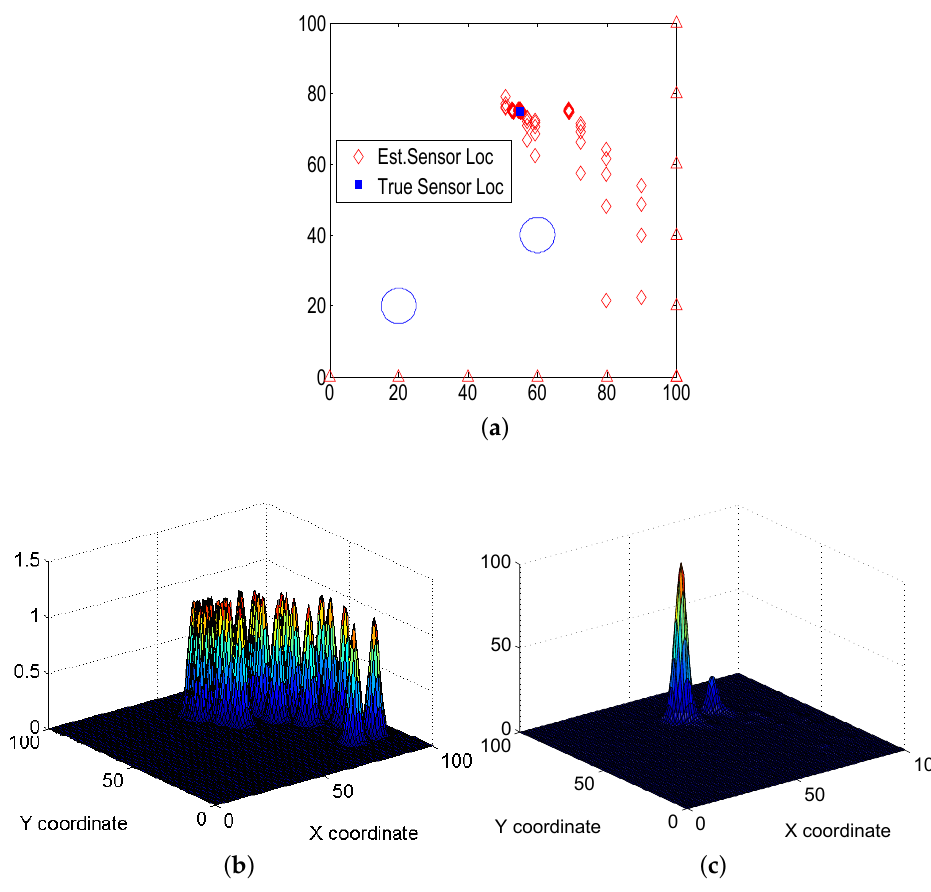
Figure 6. Depiction of the Majority Rule concept: ( a ) Network topology where blue circles represent obstructions and red triangles represent beacon nodes, ( b ) bivariate Gaussian pdfs centered at the candidate location estimates, and ( c ) summation of the Gaussian pdfs, shows final location estimate